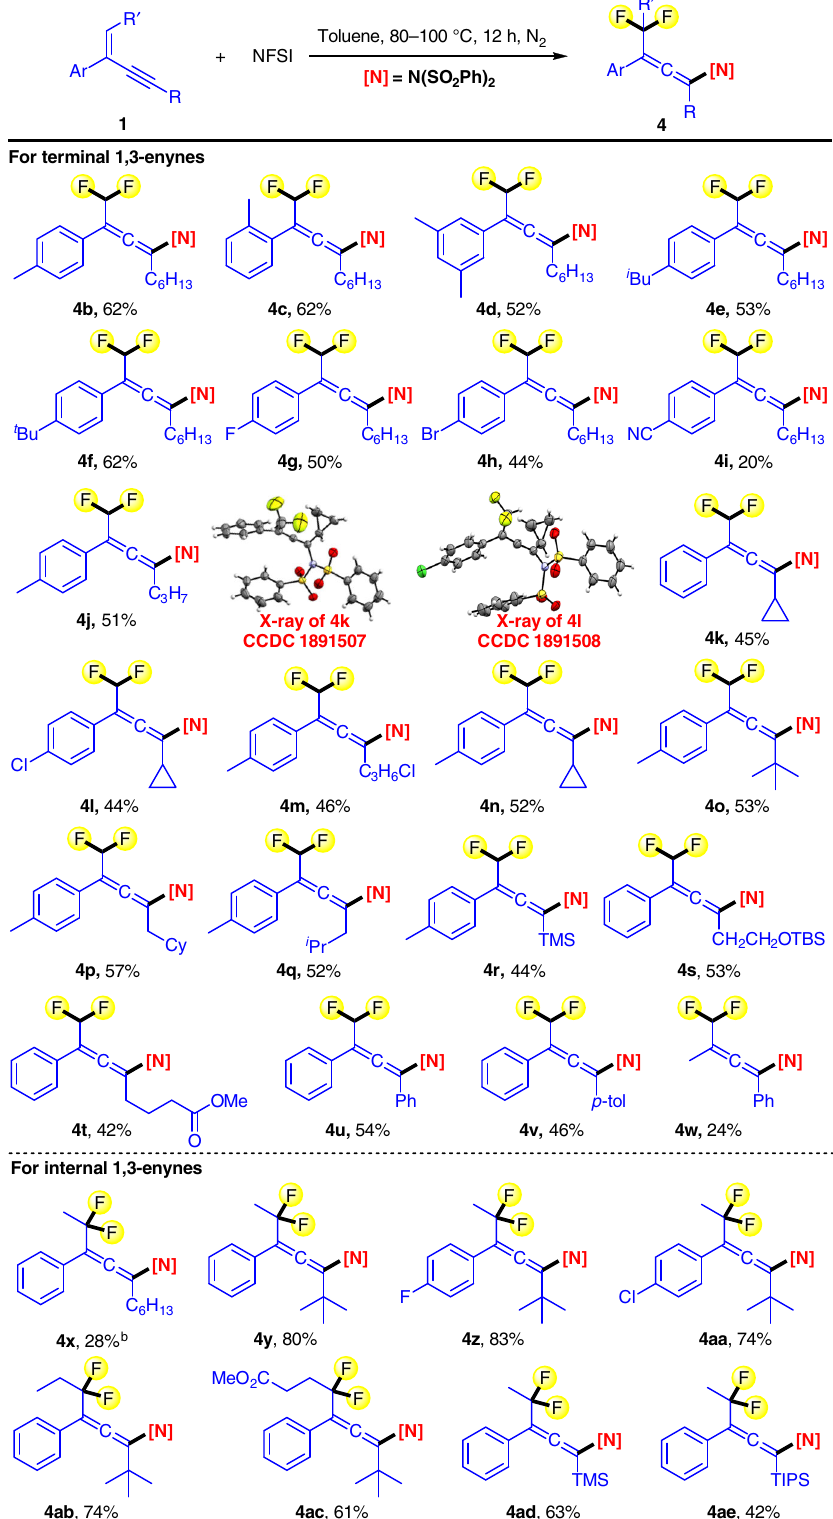
Fig. 2 Substrate scope of 1,3-enynes. Reaction conditions: 1,3-enyne (1, 0.5mmol), NFSI (1.5 mmol), toluene (1 mL), 80-100 o C, N 2 atmosphere, Isolated yield. a With CHCl 3 (1 mL) as the solvent. b The reaction was performed in cyclohexane and the mono fl uoromethylated allene 3x was obtained in 46%